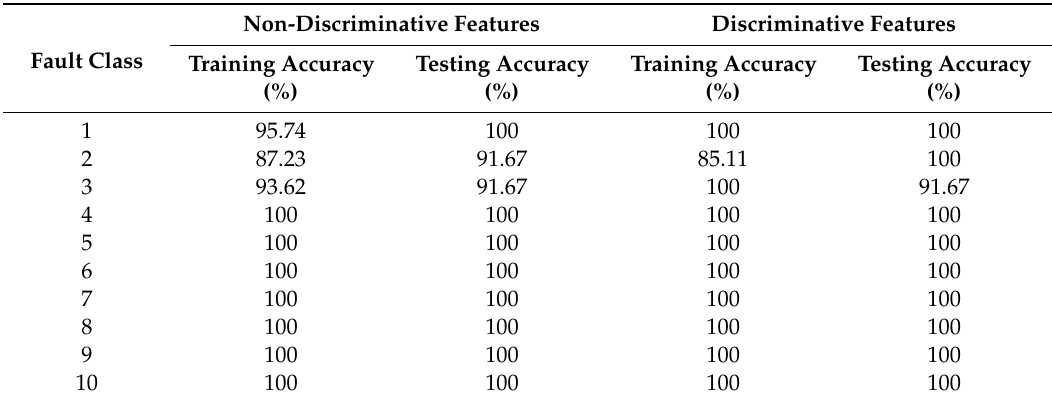
Table 3. The bearing fault diagnosis results using non-discriminative and selected discriminative features.